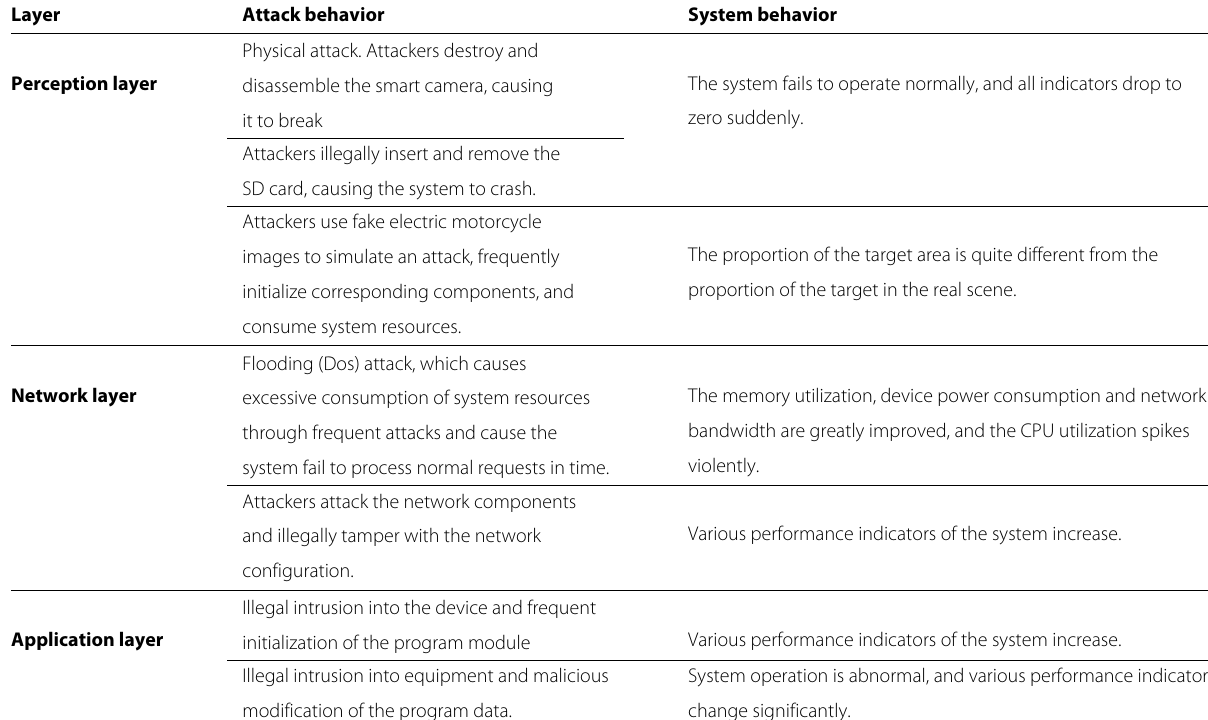
Table 1 Security risks faced by our system and the behavior of the system at risk Layer Attack behavior System behavior Physical attack. Attackers destroy and Perception layer